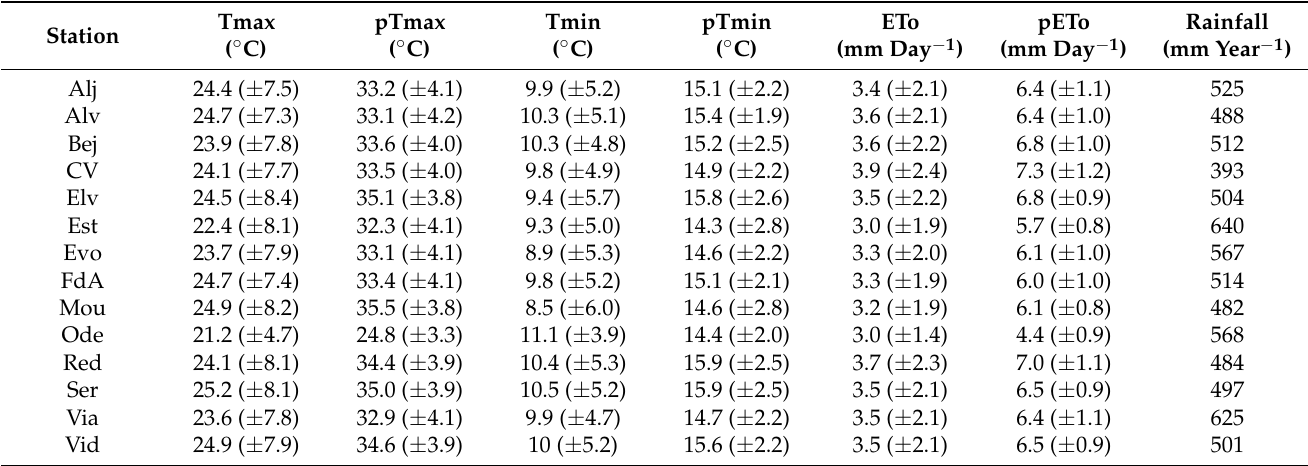
Table 2. Yearly mean and standard deviation of maximum (Tmax) and minimum (Tmin) temperatures, reference evapotran- spiration (ETo), and rainfall at each assessed